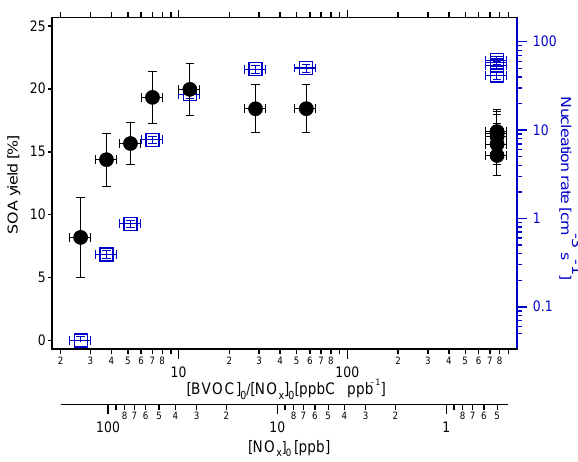
Figure 1. Measured SOA yield from PM max (black circles) and rates of new particle formation (blue squares) for the β -pinene photoox- idation as a function of the ratio of the initial hydrocarbon to the initial NO x concentration and as a function of the initial NO x con- centration. Each point corresponds to one experiment. The errors in nucleation rate and [NO x ] were estimated to be ± 10%. The er- ror in SOA yield was estimated from error propagation using the sum of the systematic error, correction procedure error and error in BVOC data. Note that the horizontal error bars are associated with the BVOC / NO x